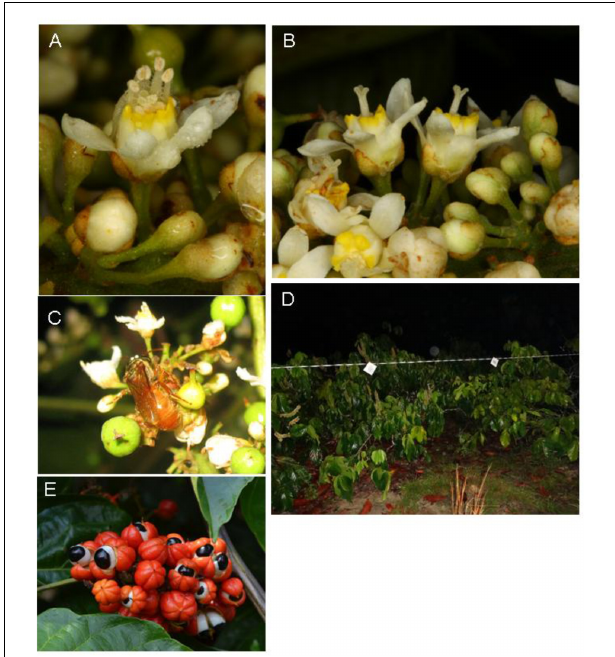
FIGURE 1 | Male (A) and female (B) guarana flowers. Megalopta aeneicollis visiting a guarana flower (C) . String and filter papers impregnated with synthetic mixtures or solvent only, as used in the biotests (D) . Fruits of guarana (E)